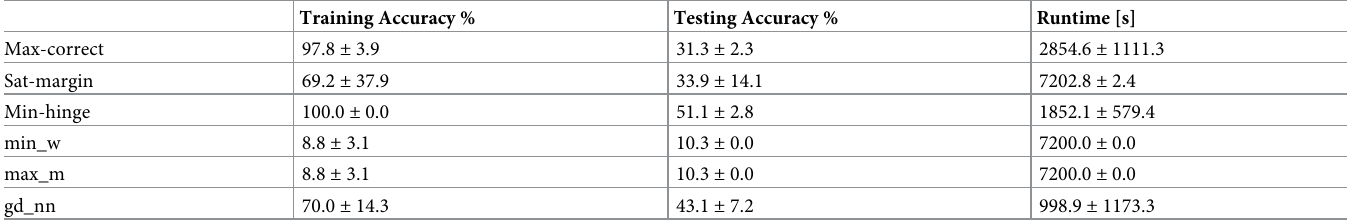
Table 1. Average results for Experiment 1 over five runs with standard